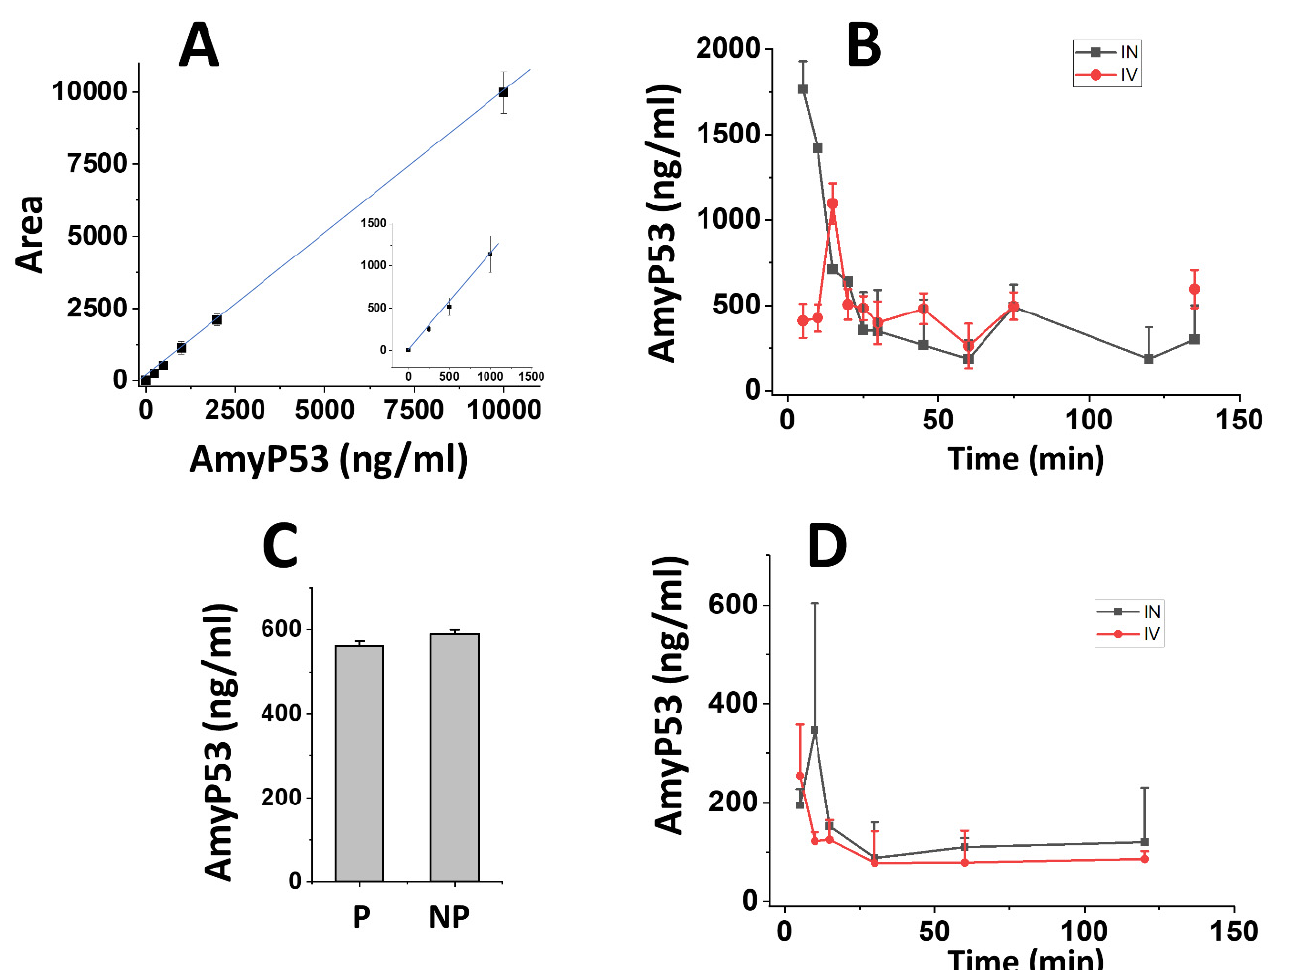
Figure 5. Pharmacokinetics studies of AmyP53 administered in rats by either the intravenous or intranasal routes. ( A ) Calibration curve of AmyP53 detection in brain homogenates after methanol extraction and quantification by LC–MS. The insert shows the 250–1000 ng/mL range. Data are expressed as mean ± SD (n = 4). ( B ) At the indicated time following intravenous (red symbols) or intranasal administration (black symbols), brain homogenates were prepared and extracted with the methanol method, and AmyP53 was quantified by LC–MS. Data are expressed as mean ± SD (n = 3). ( C ) Comparison of AmyP53 determinations in perfused (P) and nonperfused (NP) brain 30 min after intranasal injection. The data considered the time required for perfusion (15 min). Data are expressed as mean ± SD (n = 3). ( D ) AmyP53 quantified in whole blood samples after intravenous (red symbols) or intranasal administration (black symbols). Data are expressed as mean ± SD (n = 3). In panel C, the differences were not statistically significant ( p > 0.05, Kruskal–Wallis test). Table 2. Pharmacokinetics parameters following the intravenous and nasal administration of AmyP53 in rats.